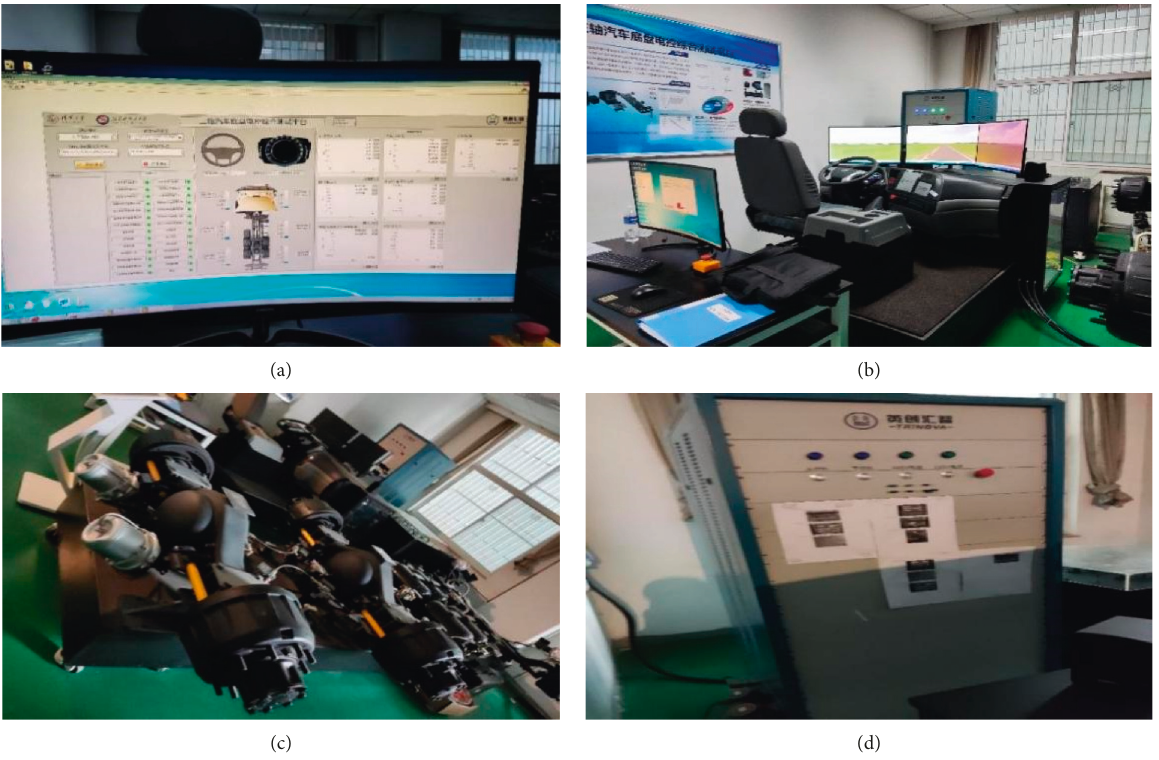
Figure 27: Operational physical map of HIL platform. (a) Hardware test platform. (b) Hardware experimental driving simulator. (c) Dongfeng three-axle chassis. (d) Hardware electrical